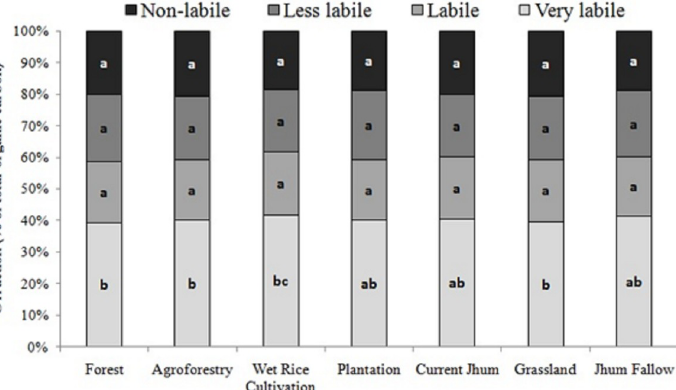
Fig 2. Distribution of soil organic carbon fractions of different lability (% of total organic carbon) in different land use types (0–45 cm soil depth) in Mizoram. (Letters a, b, c describe whether the proportions of different carbon fractions are significantly different or not, where proportions with same letters indicate no significance (p < 0.05), within and across the land use types under